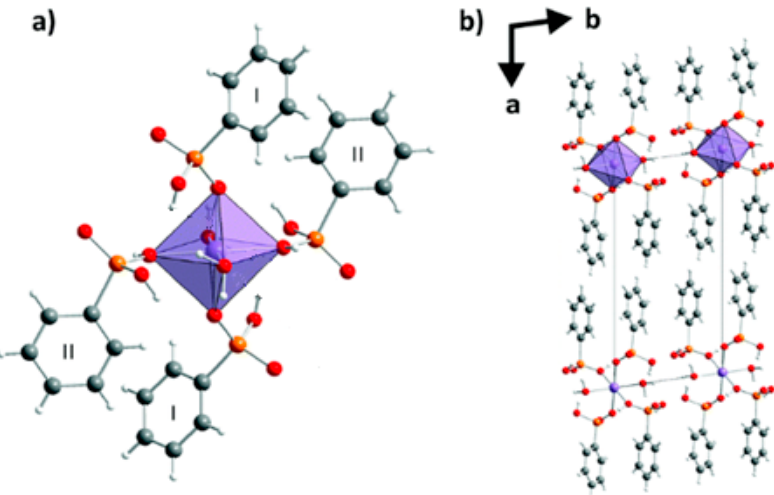
Figure 10. Crystal structure of [Mn(HO 3 PPh) 2 -(H 2 O 3 PPh) 2 (H 2 O) 2 ] (1), with respective values for the isomorphic compounds based on Co (2) and Ni (3) . ( a ) Coordination sphere of the metal ion. ( b ) Structure of 1 shown along the c -axis (b). Hydrogen atoms are omitted for clarity. Colour code: purple: manganese, red: oxygen, orange: phosphorus, grey: carbon, light grey: hydrogen. Adapted with permission from reference. [57]. Copyright 2016, Royal Society of Chemistry.